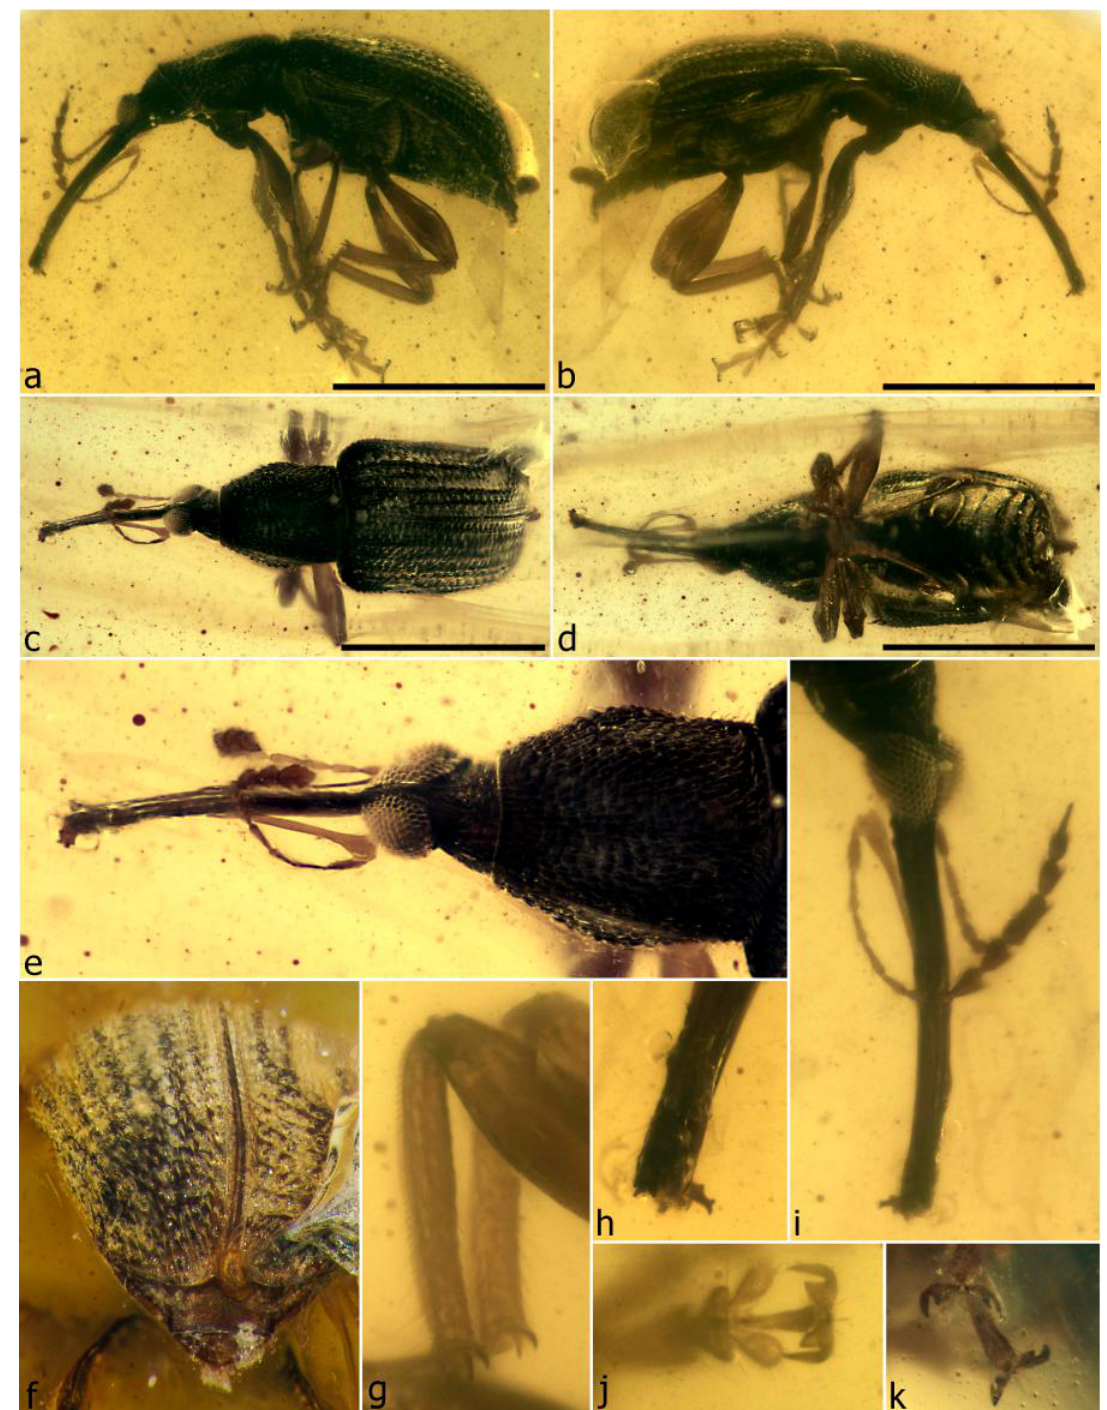
Figure 87. Bowangius zhenuai sp. n., holotype. Habitus, left ( a ); habitus, right ( b ); habitus, dorsal ( c ); habitus, ventral ( d ); head and pronotum, dorsal ( e ); apex of elytra and abdomen, caudal ( f ); metatibiae ( g ); apex of rostrum and mandibles, left ( h ); head and rostrum, oblique right ( i ); tarsus ( j ); tarsal claws ( k ). Scale bars: 1.0 mm (a–d).